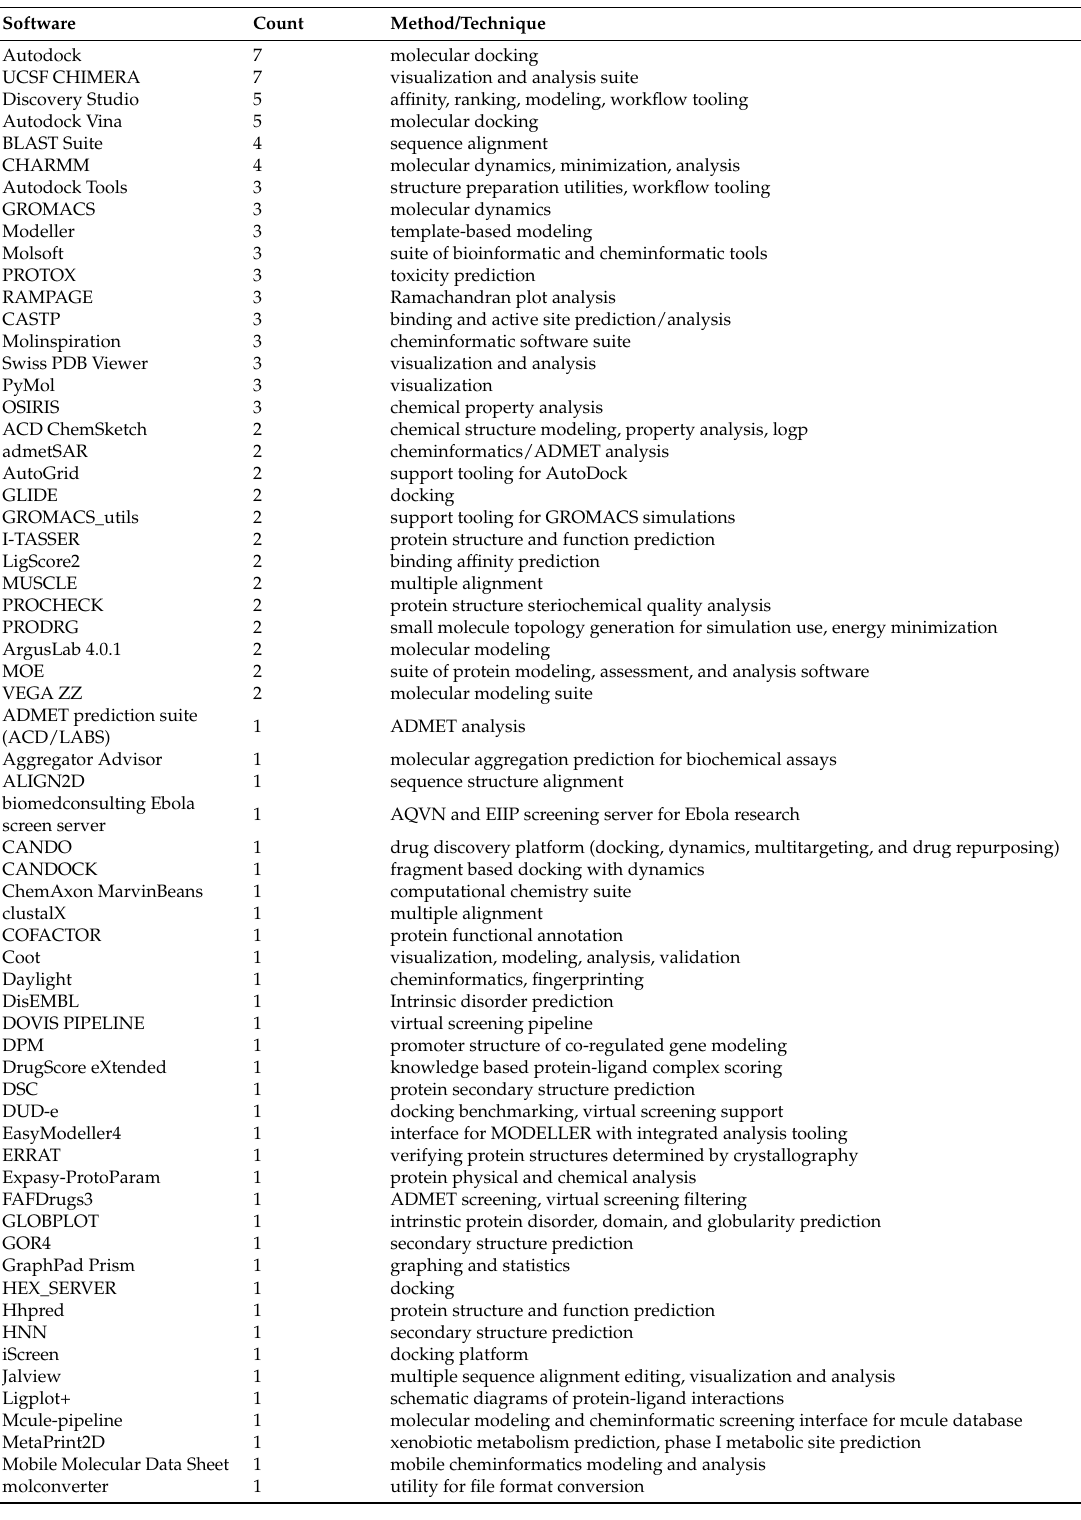
Table 5. Frequency of software used in the studies reviewed. A nonexhaustive sample of the types of software and servers and their minimal frequency of use for computational drug discovery methods and techniques used in the treatment against EVD. Although researchers converge on a few popular programs for common methods like molecular docking or molecular dynamics, there exists an abundance of options for nearly every